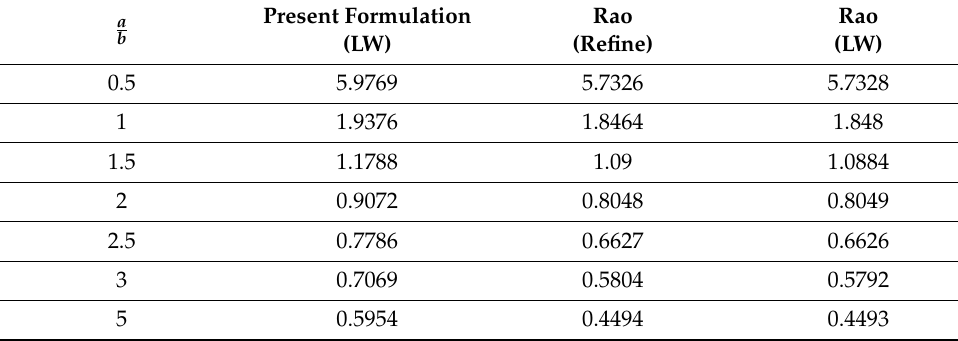
Table 3. Comparison of non-dimensional fundamental frequencies ω of (0 ◦ /90 ◦ /core/0 ◦ /90 ◦ ) = = 10 and h 3 sandwich plate with a h h 1